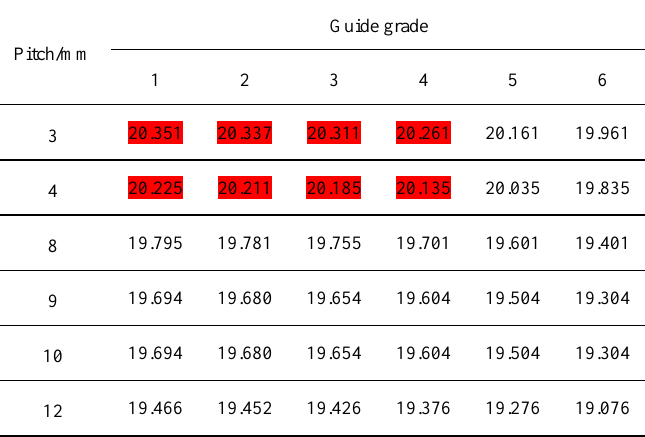
Table 8. available height of the rail when the grade is 8 (mm)